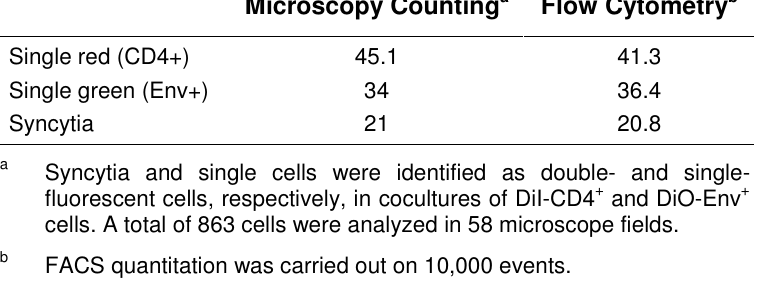
Percentage of Syncytia and Single Cells Obtained by Visual Counting and Flow Cytometry Microscopy Counting